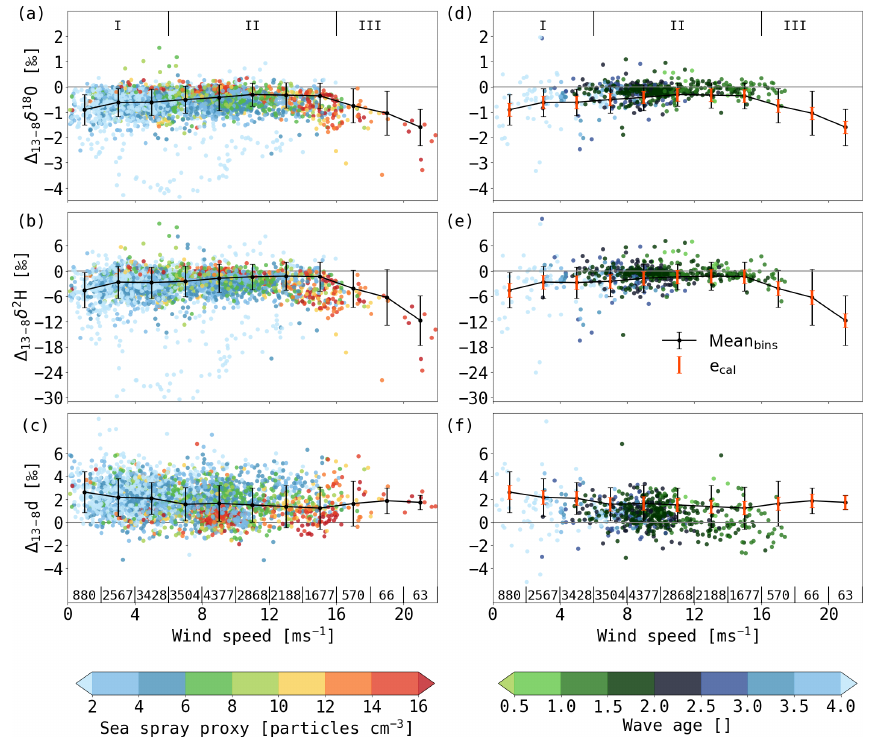
Figure 10. Scatter plots of the vertical differences between SWI-13 and SWI-8-ps for (a, d) δ 18 O ( (cid:49) 13 − 8 δ 18 O), (b, e) δ 2 H ( (cid:49) 13 − 8 δ 2 H) and (c, f) d ( (cid:49) 13 − 8 d ) versus wind speed for legs 1–3. The colours show the sea spray proxy (a–c) or wave age (d–f) . The black line represents the mean and standard deviations of the vertical differences in 2ms − 1 bins. Orange error bars in panels (d–f) show the averaged uncertainty e cal due to the post-processing (as presented in Sect. 3) which amounts to 0.25 for δ 18 O, 1.63 for δ 2 H and 0.59 for d . The vertical lines at the bottom indicate the 2ms − 1 bins labelled by the number of measurement points per bin. The labels (I, II, III) at the top correspond to the wind regimes (see text and Fig. 11). Fewer points are shown in panels (d–f) than in (a–c) , because less wave age than sea spray data are available. The data are shown in 5min resolution and only every third time step is shown in the scatter